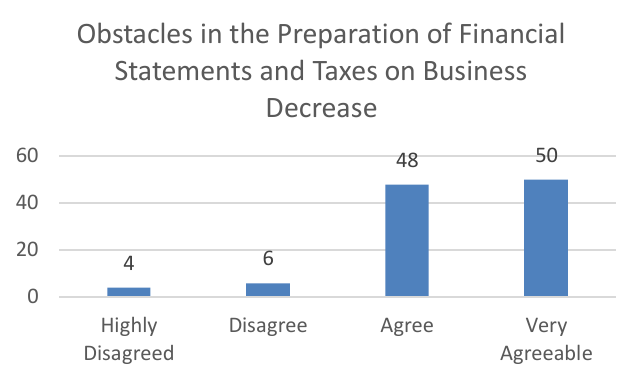
Figure 5: Obstacles in the Preparation of Financial Statements and Taxes on Business Decrease; Source: Own elaboration